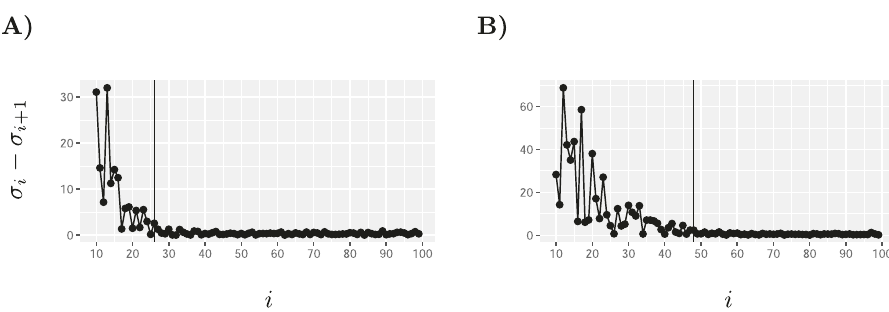
Fig. 5 Differences between consecutive singular values. A the rank was set to k = 26 in the puri fi ed PBMCs experiment. B Rank was set to k = 48 for the mouse visual cortex